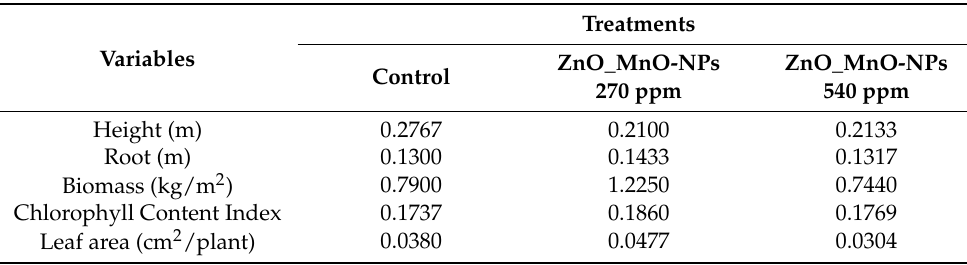
Table 5. Effect of ZnO–MnO NPs sprays on growth of cabbage ( Brassica oleracea var. capitata ) cultivar Franco.